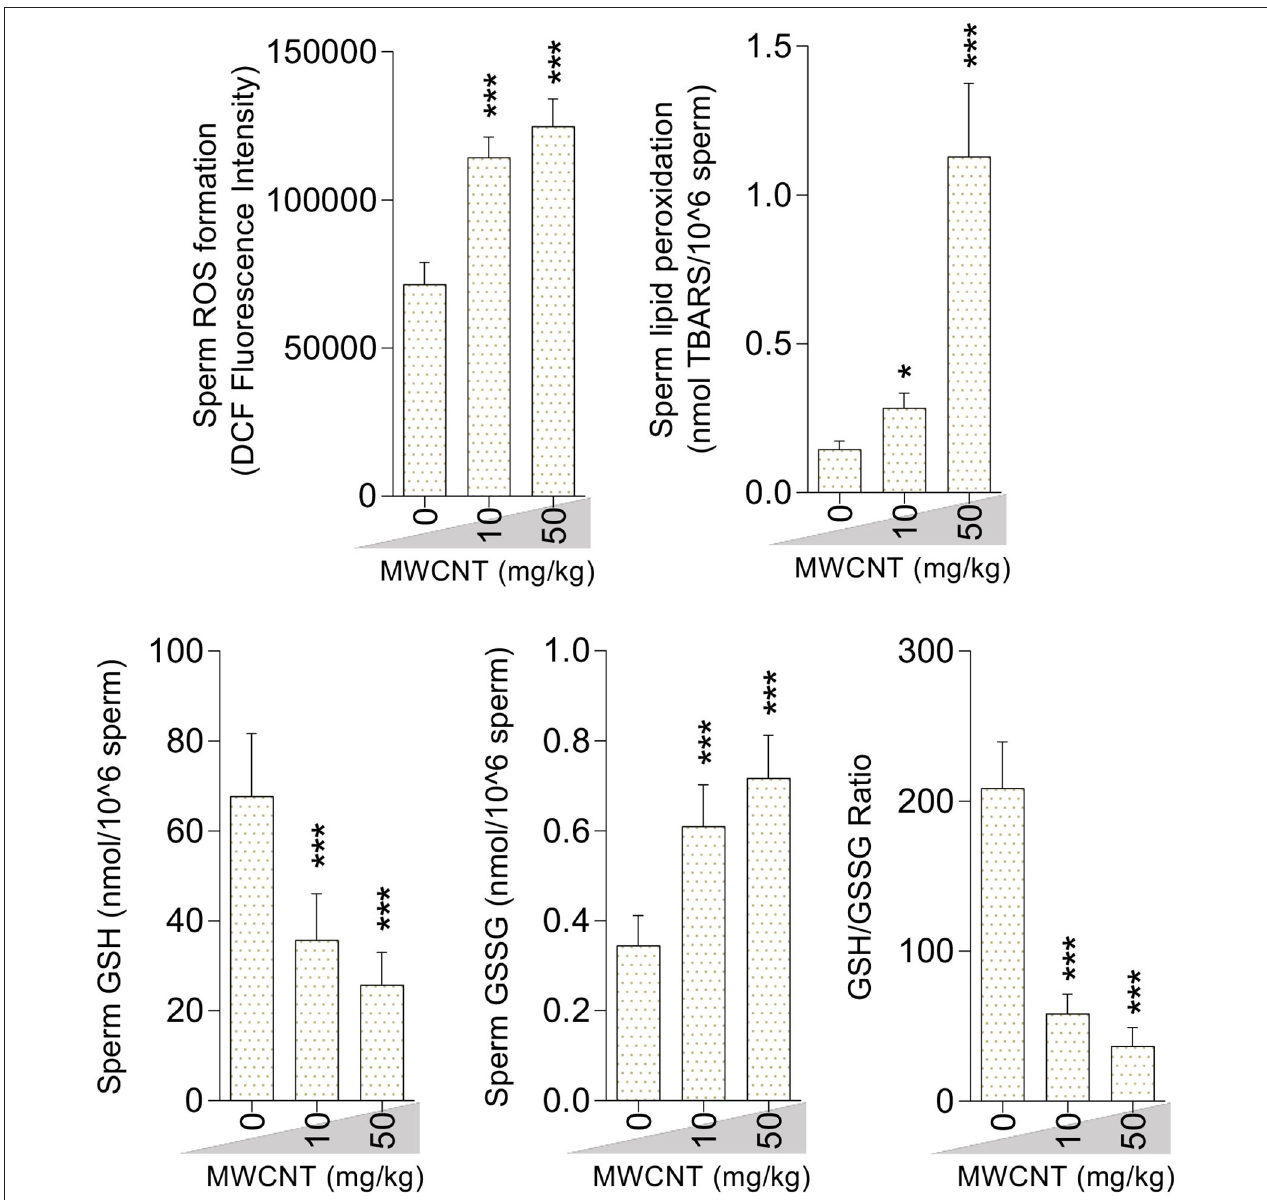
FIGURE 8 | Effect of multi-walled carbon nanotubes (MWCNT) on oxidative stress biomarkers in mice sperm (mean ± SEM, n = 6). Asterisks indicate significantly different from the control (0 ppm) group (* P < 0.05, *** P < 0.001).